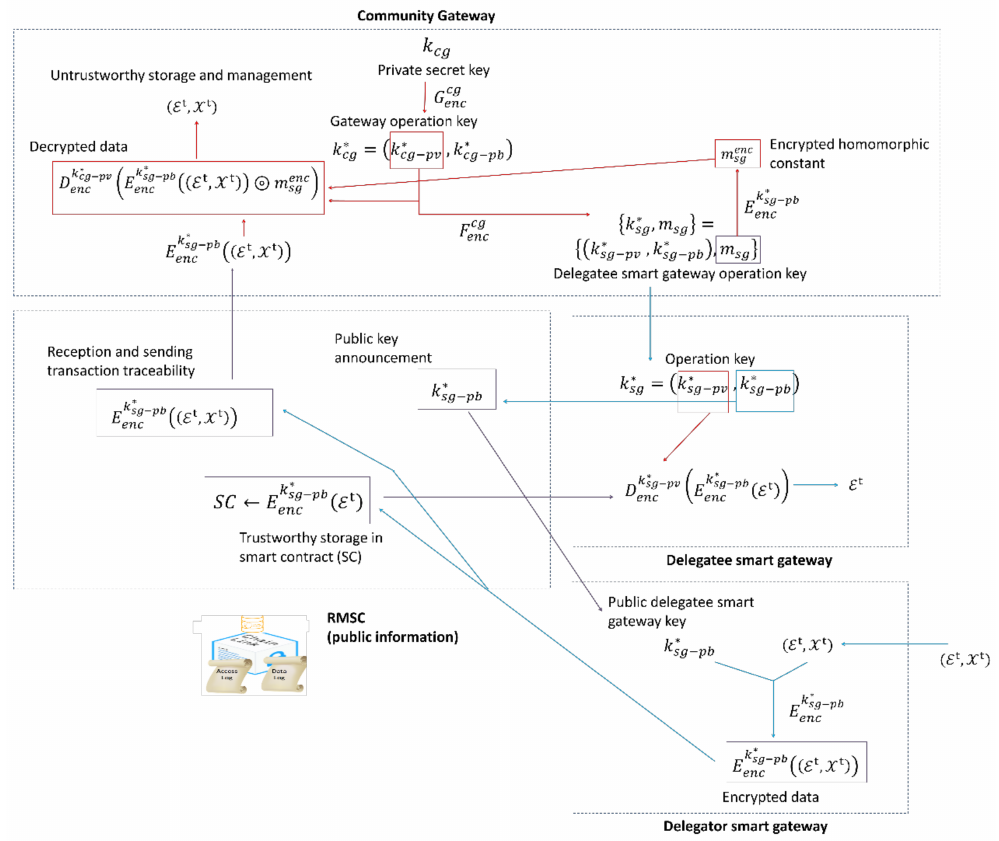
Figure 3. Architecture for the secure controller functions